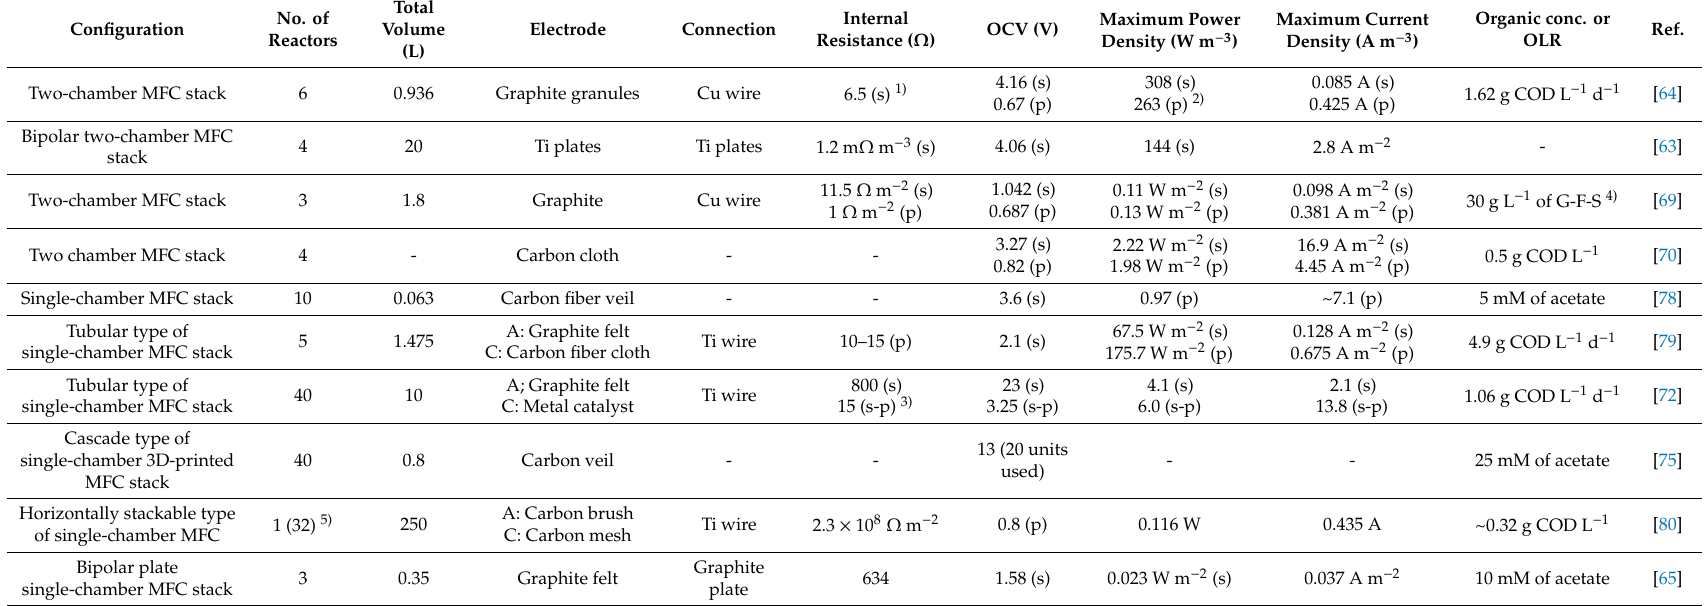
Table 2. Summary of configuration, operational condition, and performance of MFC stacks reported in the